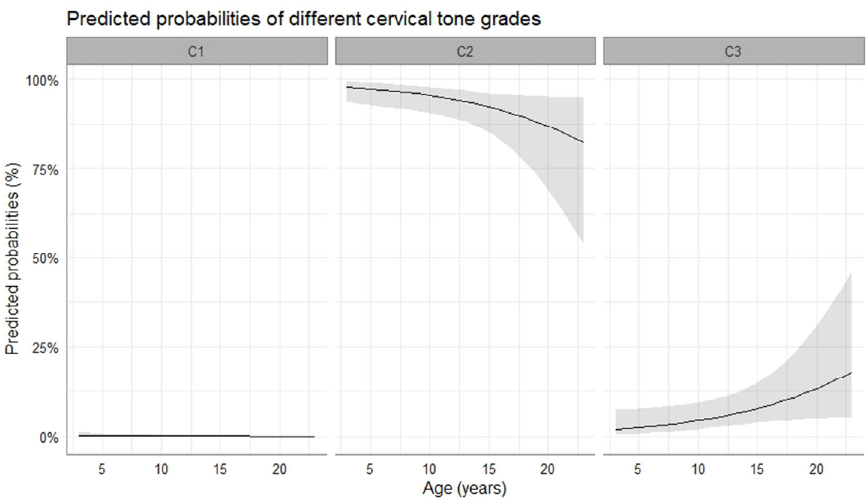
Figure 3. Mean probability (solid line) and the respective 95% confidence intervals (grey-shaded area) for the occurrence of specific cervical tone with progressing age of the mare. C1, cervix slightly flaccid and open; C2, cervix moderately flaccid and open; C3, cervix markedly flaccid and open.